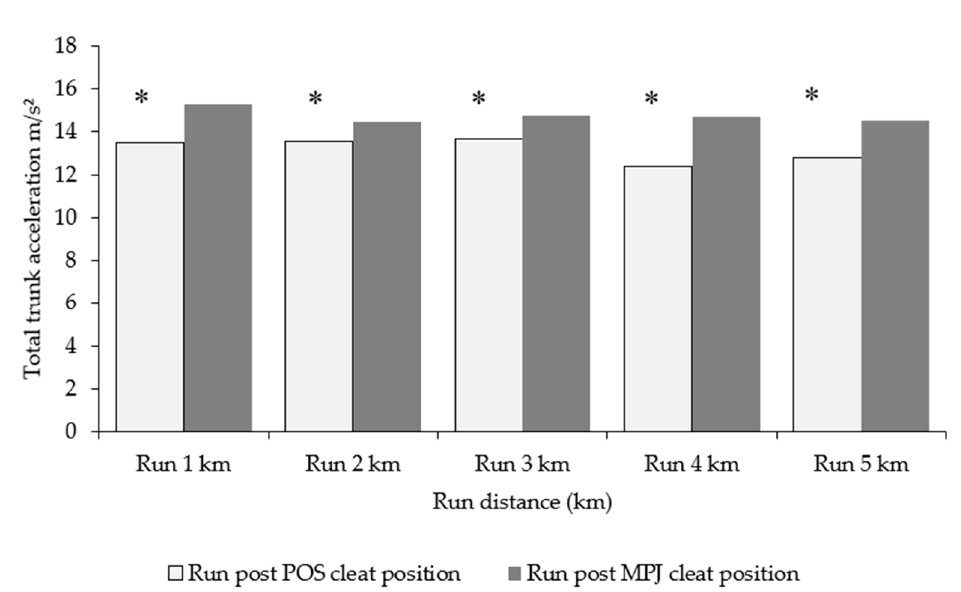
Figure 8. Total triaxial accelerations of the trunk during each 1 km epoch of running after cycling in MPJ and POS cleat positions. Acceleration presented in m/s². * Significant at p <